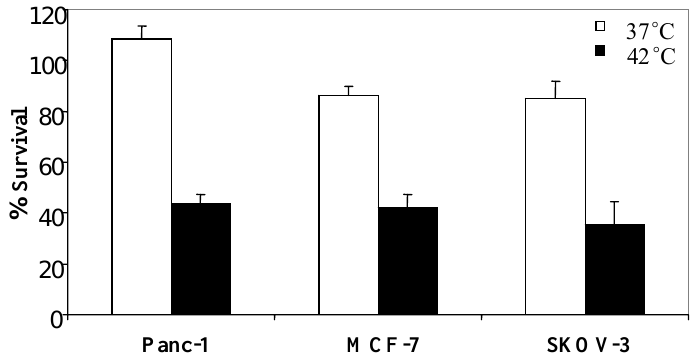
Figure 5. Effect of Tat-ELP1-L12 in different cell lines.